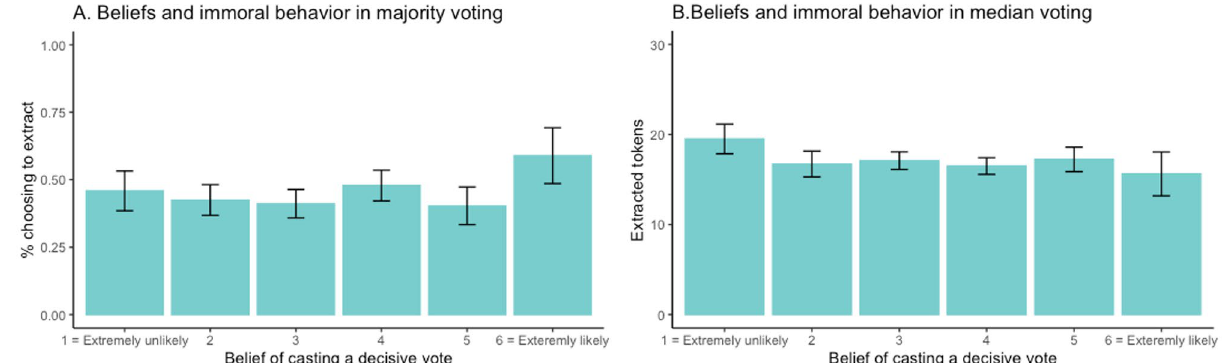
Figure 2. ( A ) Immoral behavior and beliefs of being pivotal in the majority voting condition (Study 2). ( B ) Immoral behavior and beliefs of being pivotal in the median voting condition (Study 3). Bars indicate 95% confidence